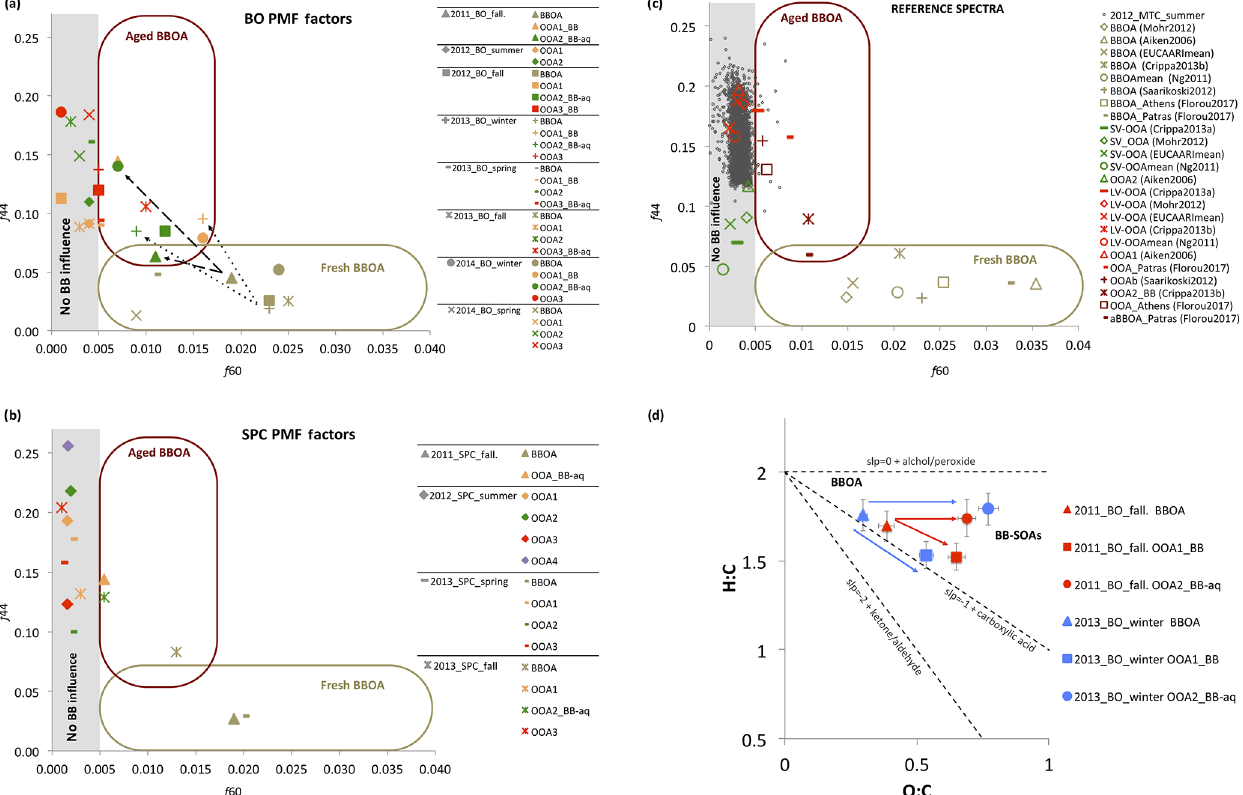
Figure 7. Influence of biomass burning emissions on SOA and their evolution processes. The plots in panels (a) , (b) and (c) show f 44 (the normalized mass spectrum at m/z 44), which is a proxy of the OA oxygenation degree, vs. f 60 (the normalized mass spectrum signal at m/z 60), which is a proxy of anhydrosugars. Different shapes of the markers identify different Supersito campaigns (a, b) or different reference spectra (c) . Different colors represent the different kinds of PMF factors: gold–green identifies BBOA primary factors, yellow, green and red the OOAs numerically ordered based on their O:C ratios. Black dots in (c) represent the measurements taken as the background level of no influence of biomass burning. Grey areas correspond to f 60 0 . 003 ± 0 . 002 representing the Cubison et al. (2010) threshold of BB influence. (d) shows a van Krevelen (VK) diagram of the BBOA and OOA-BB PMF factors obtained from the HR-ToF-AMS data analysis for both BO fall 2011 (red markers) and winter 2013 (blue markers). The line connecting BBOA and OOA-BB has different slopes, indicating different chemistry processing leading to different SOA